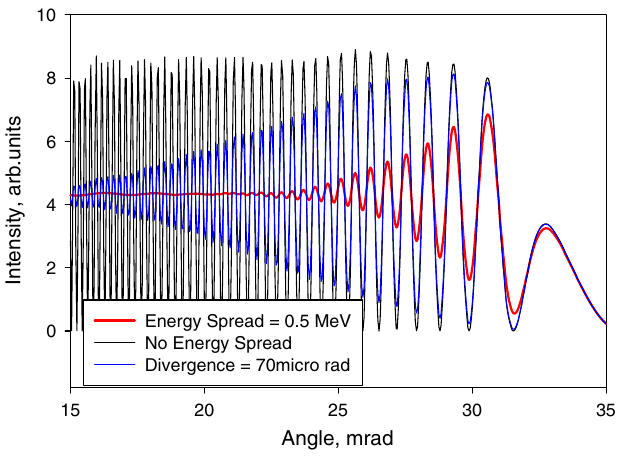
FIG. 9. OSRI from magnets (1,2) and beam energy E ¼ 100 MeV, showing how the fringes (black curve) are affected by energy spread (red curve) and divergence (blue